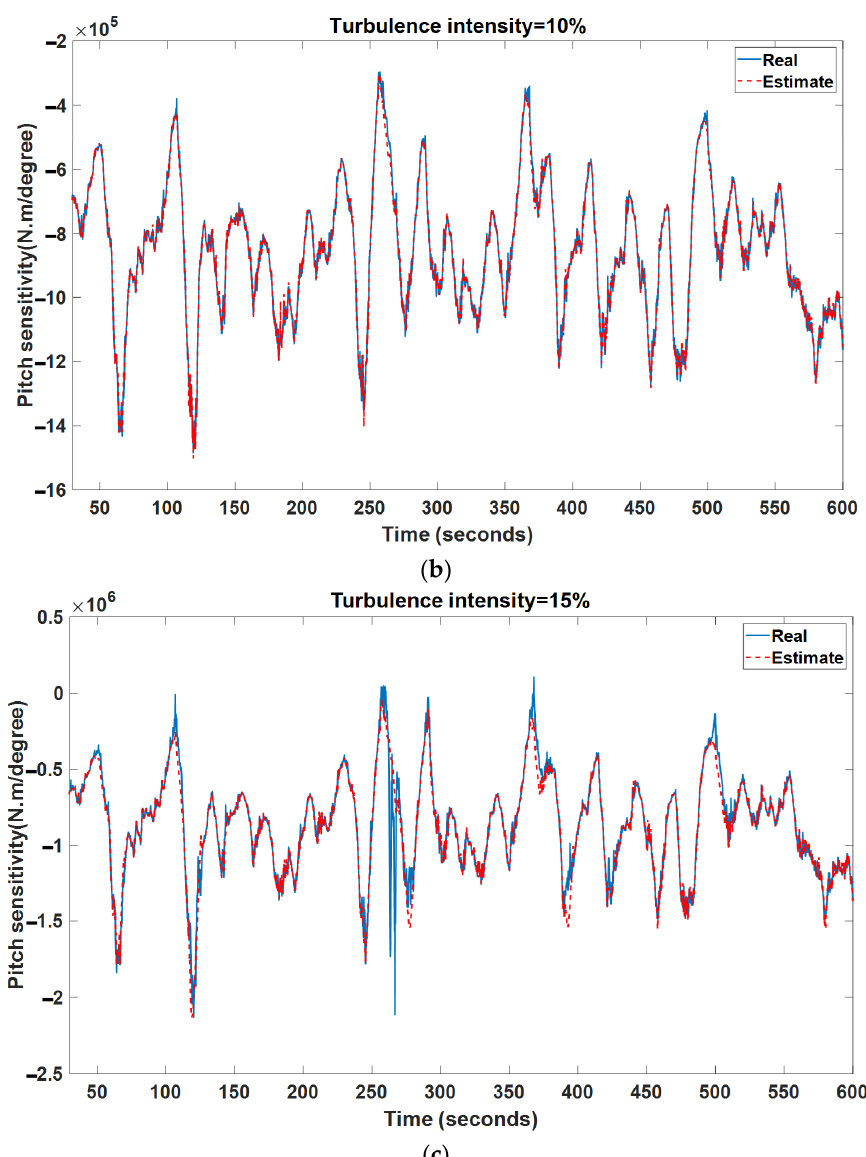
Figure 12. Pitch sensitivity estimation in different turbulence intensity and constant mean wind speed of 20 m/s by using the ANFIS system. ( a ) 5%. ( b ) 10%. ( c ) 15%.